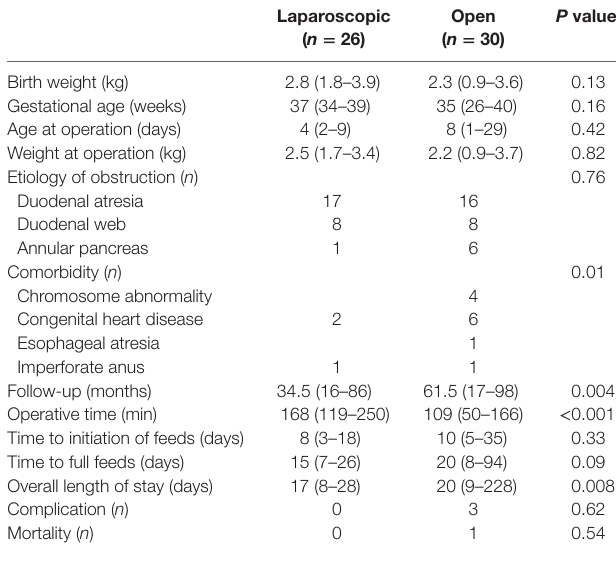
TaBle 1 | Baseline characteristics and